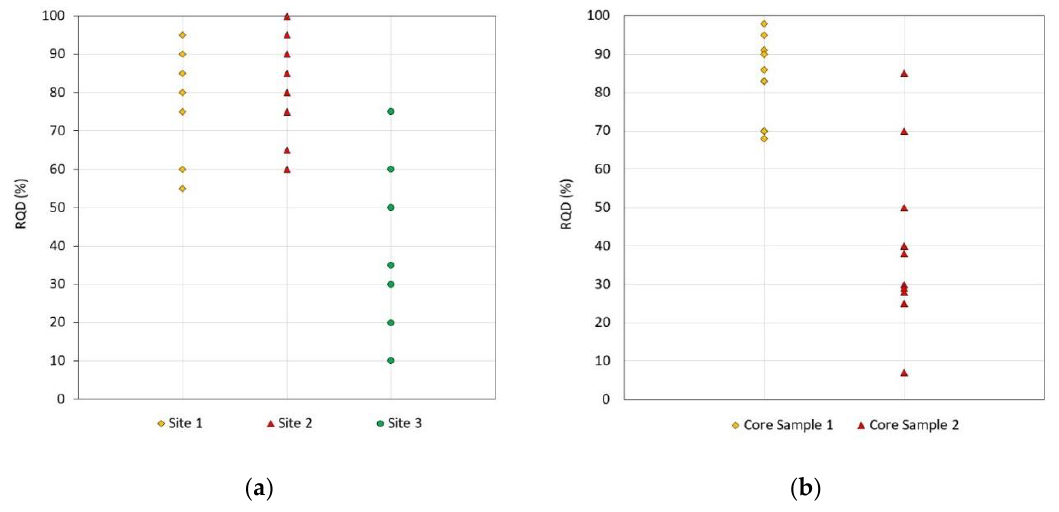
Figure 3. RQD values determined by different rock engineering professions for ( a ) three different outcrops [58] and ( b ) two core samples.